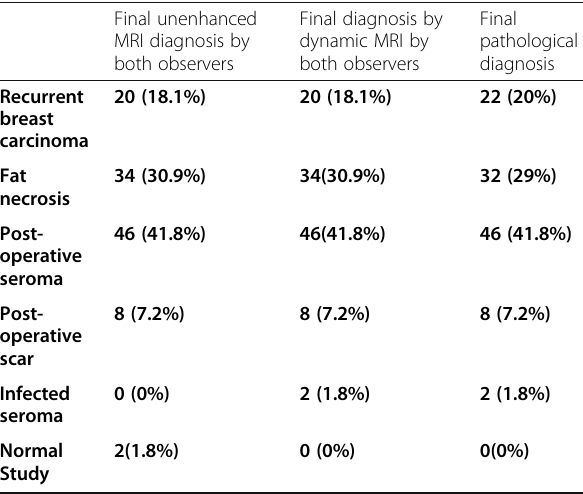
Table 5 Showed comparison between the final diagnosis by unenhanced MRI by both observers, final diagnosis by dynamic MRI by both observers, and the final pathological diagnosis